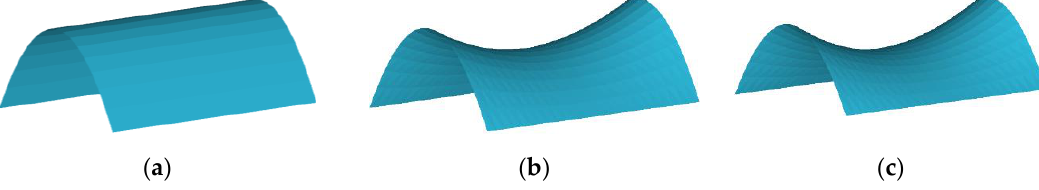
Figure 4. Shape variation of Model 1 during the optimization process: ( a ) Initial guess; ( b ) 20th step; and, ( c ) 200th/400th step (optimal).